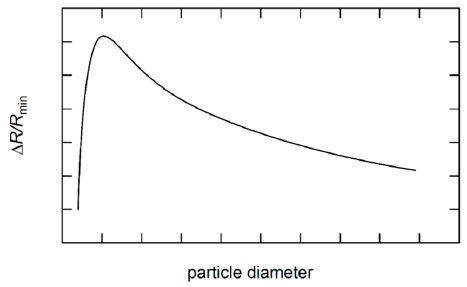
Figure 14. Schematic illustration of the granular GMR effect in dependence of the particle size. The dependence of the granular GMR on the ferromagnetic volume fraction is comparable to the particle size dependency: At low ferromagnetic volume fractions, the particles are small and few in number, therefore only a small granular GMR is measurable. With increasing ferromagnetic volume fraction, the granular GMR increases until it reaches the optimum value at a ferromagnetic volume fraction between 15% and 30%, depending on the used material system. Thereafter, it decreases with an increasing ferromagnetic volume fraction as the particles become larger and more densely packed